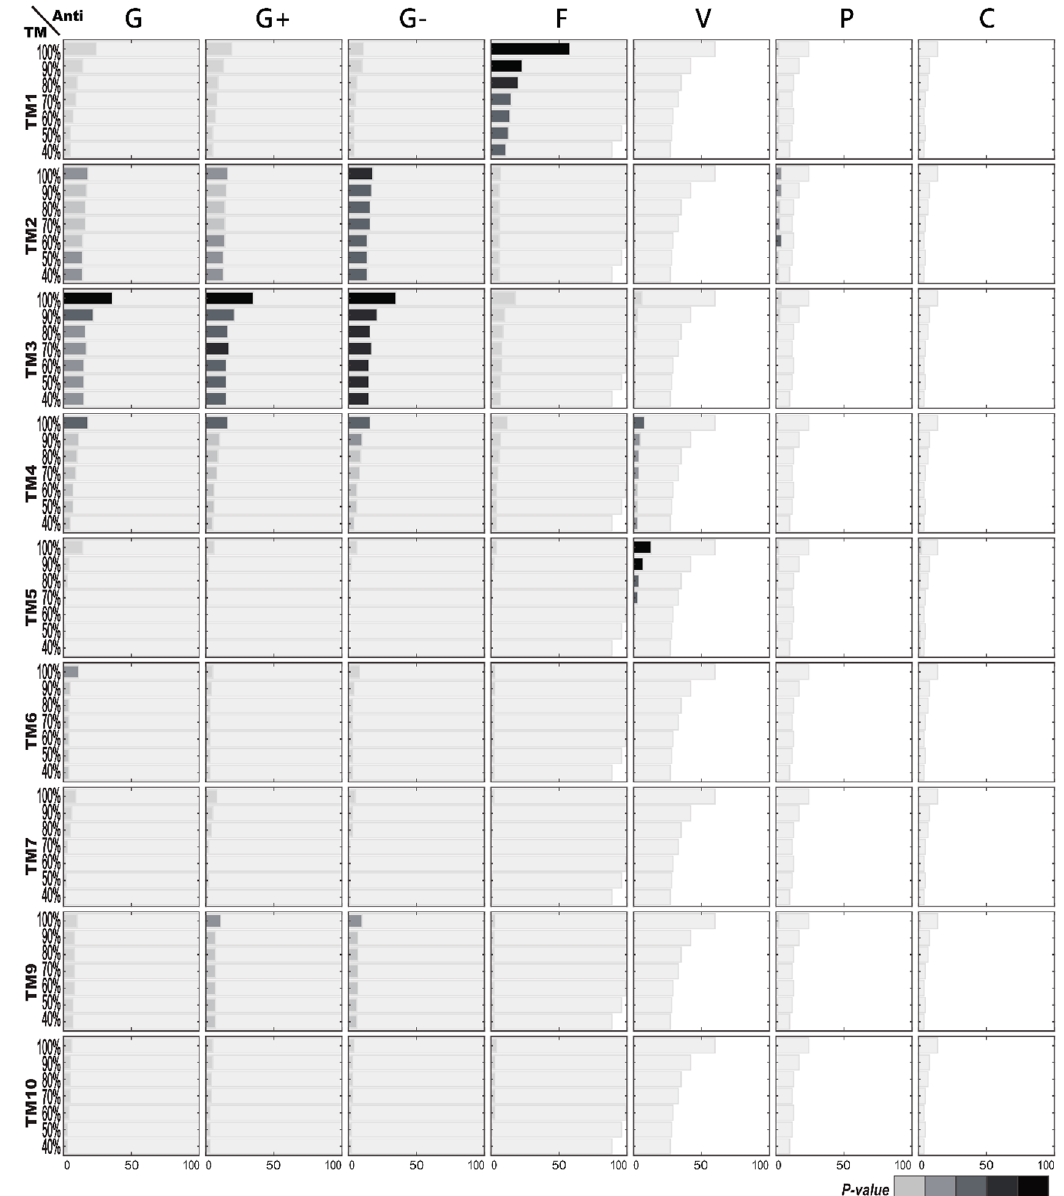
Figure 6. TM (template modeling) structural enrichment analysis of antimicrobial peptides (AMPs) with respect to AMP functions. The X -axis and Y -axis are, respectively, the number of AMP sequences and the percentage of sequence identity. The bar in light gray indicates the potential maximum number of AMP sequences within the specific TM cluster. TM8 was discarded because only the structural clusters that contain at least five AMPs are displayed here. Abbreviations: C, anticancer; F, antifungal; G, antibacterial; G+, anti-Gram+; G-, anti-Gram-; P, antiparasitic; V, antiviral.